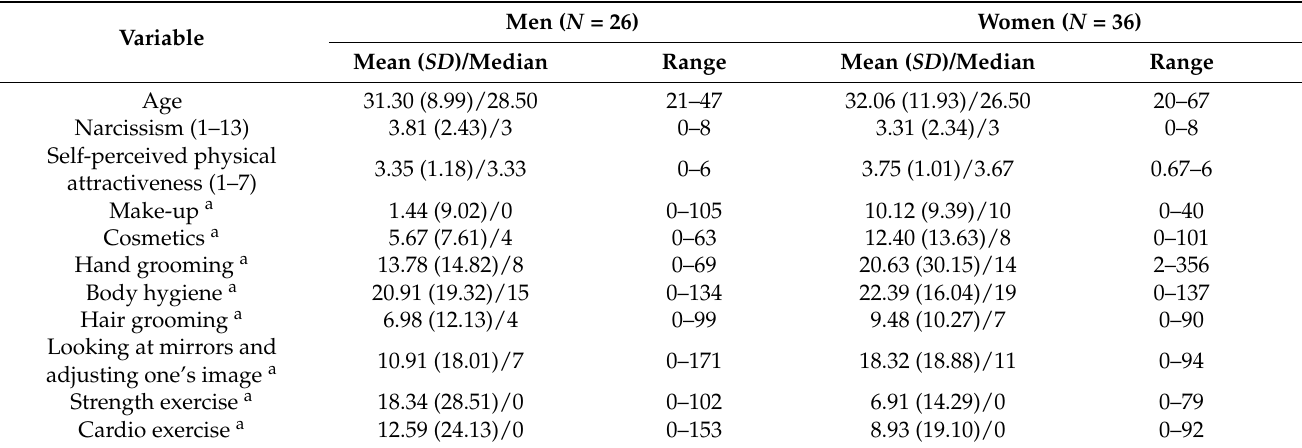
Table 1. A summary of participants’ characteristics.